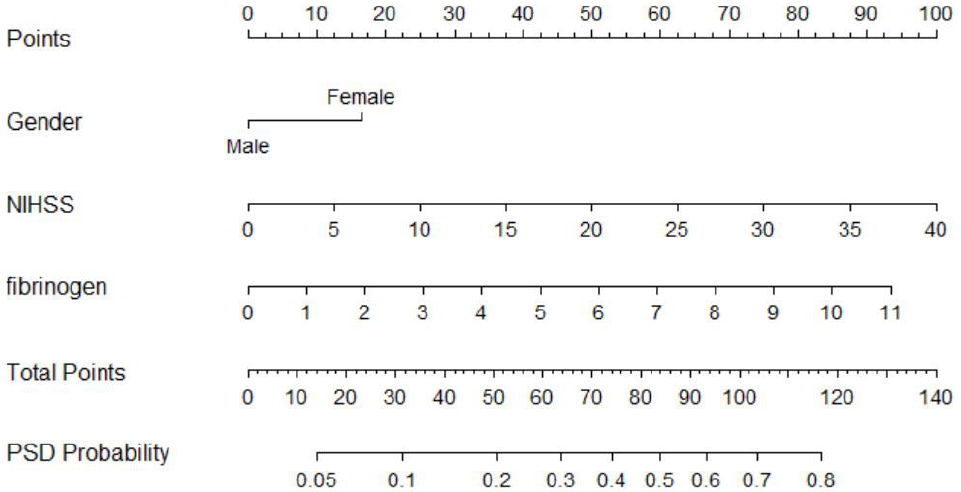
Figure 3. Nomogram predicting Post-stroke depression of acute ischemic stroke at discharge. NIHSS: National Institutes of Health Stroke Scale.